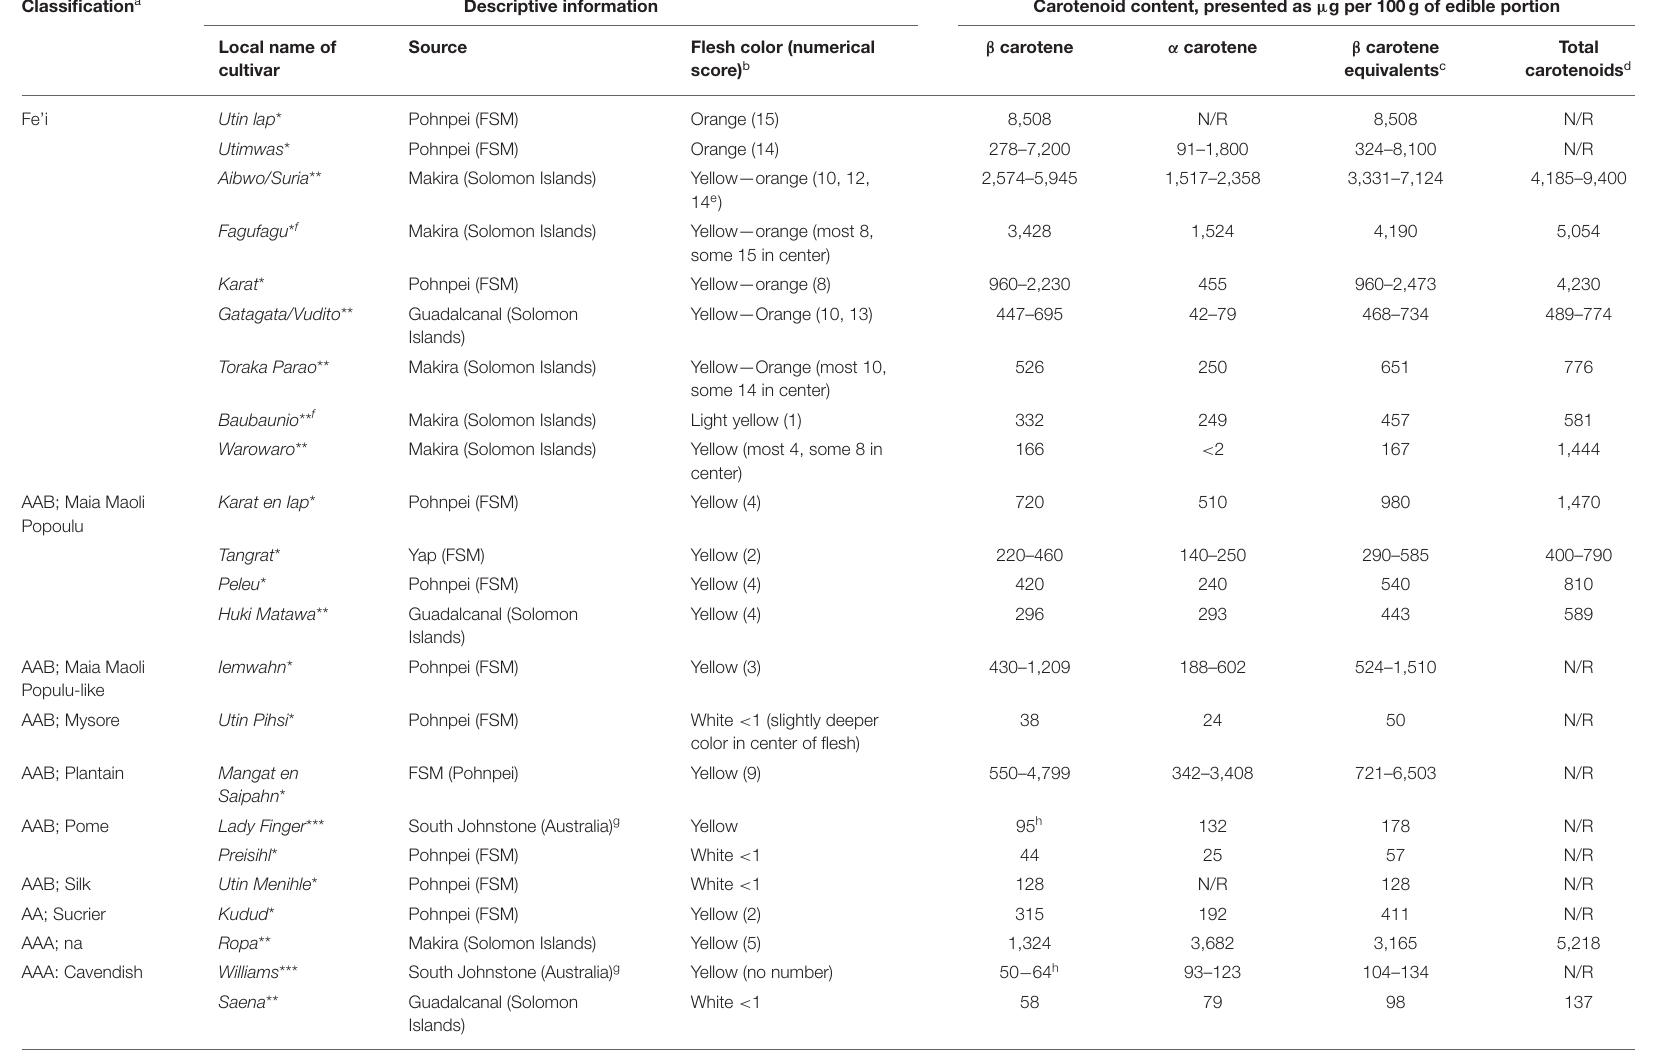
TABLE 1 | Carotenoid composition of selected Musa found in Pacific